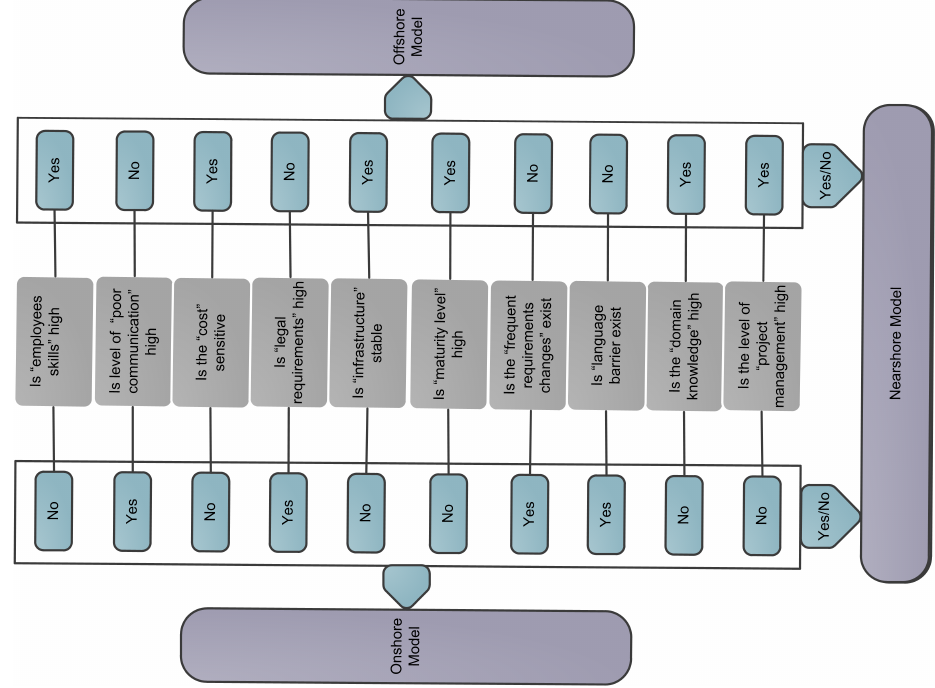
Figure 4. Sourcing framework of application maintenance